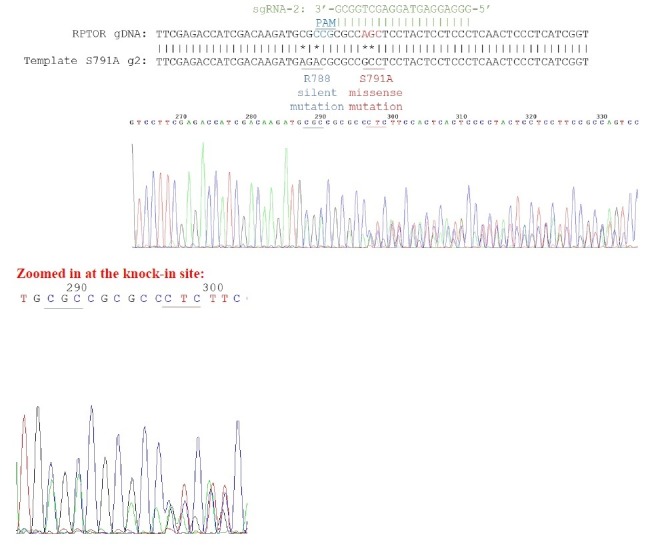
Sequencing chromatogram for heterozygous knock-in.3 peaks can be observed in the chromatogram.For example, for the nucleotides underlined in red, you can see 3 distinct peaks for the first 2 nucleotides.